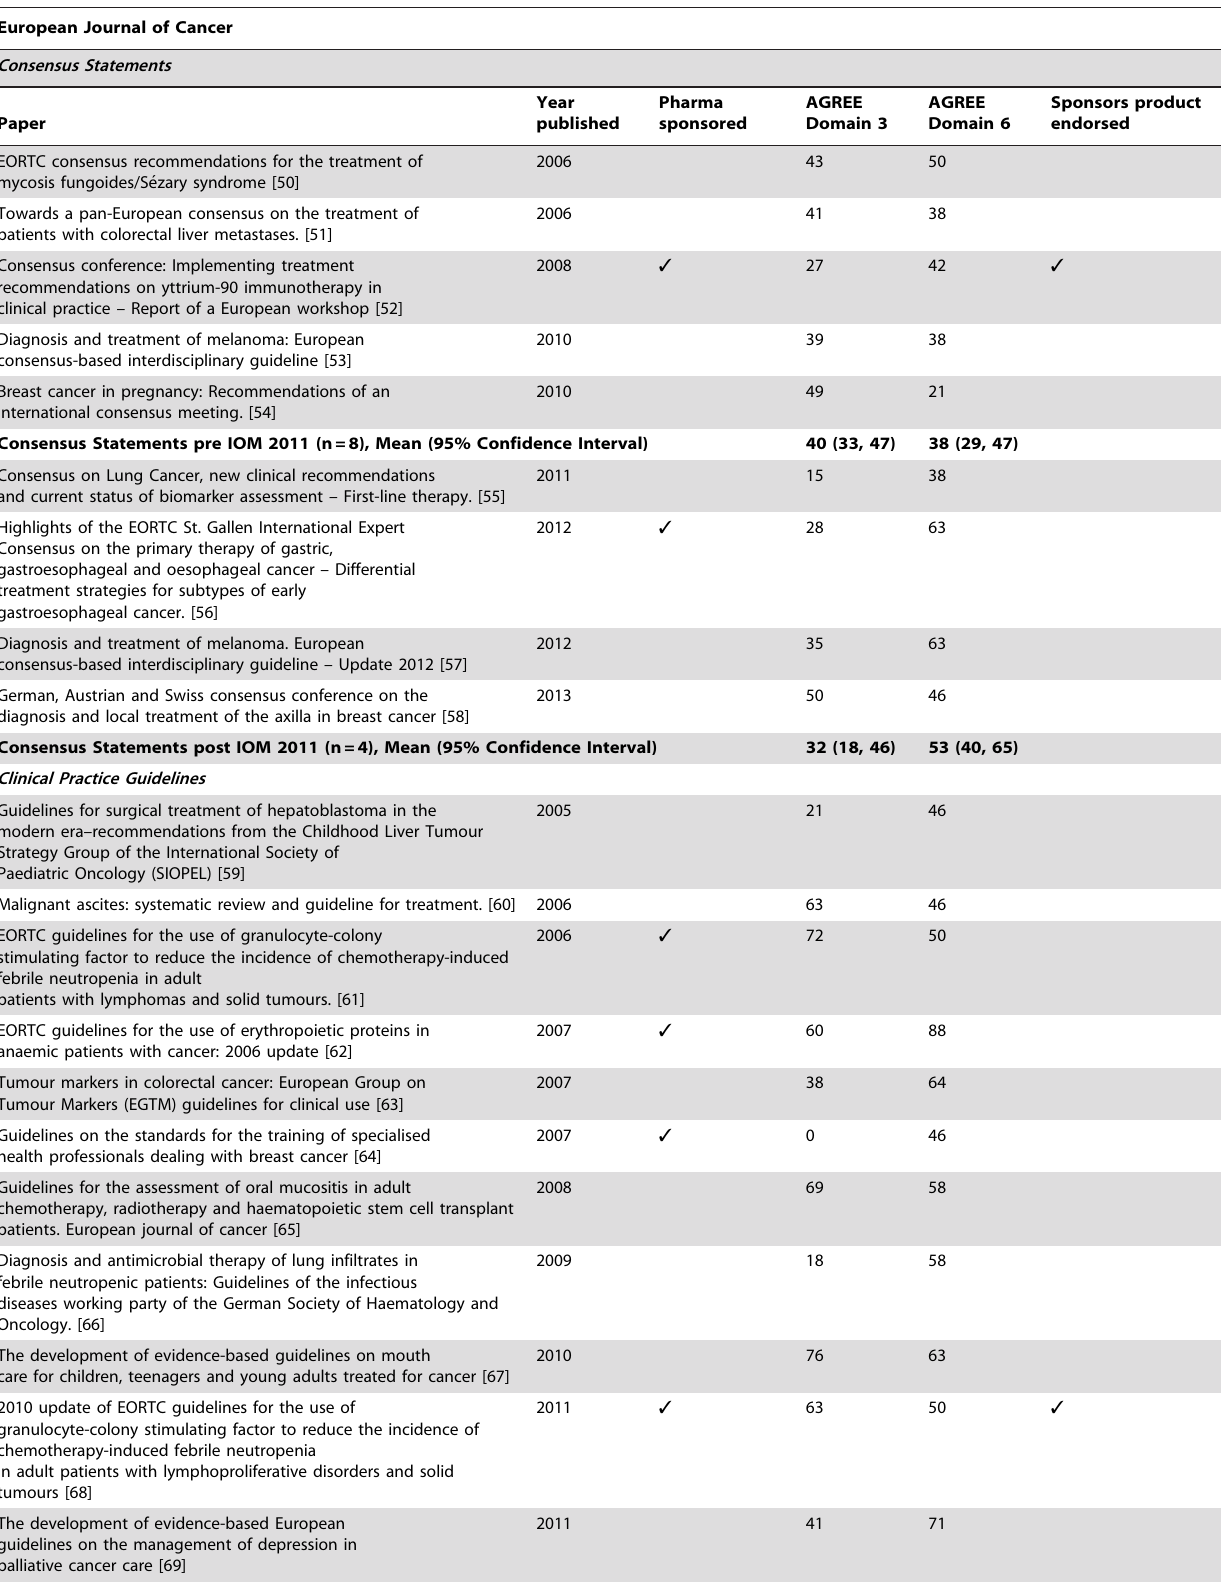
Table 5. European Journal of Cancer Consensus Statements and Clinical Practice